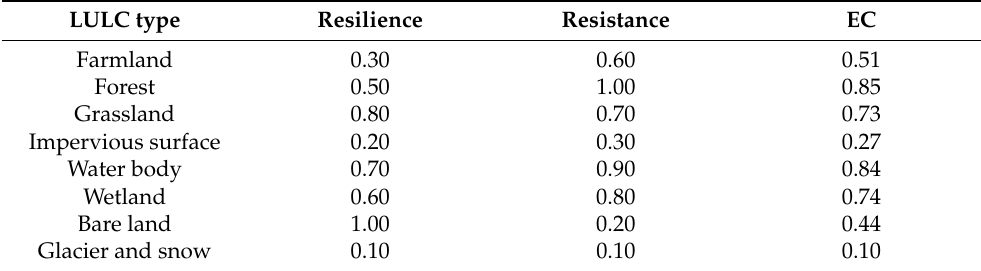
Table 1. Ecosystem elasticity coefficient of land-use types in the Qinling-Daba